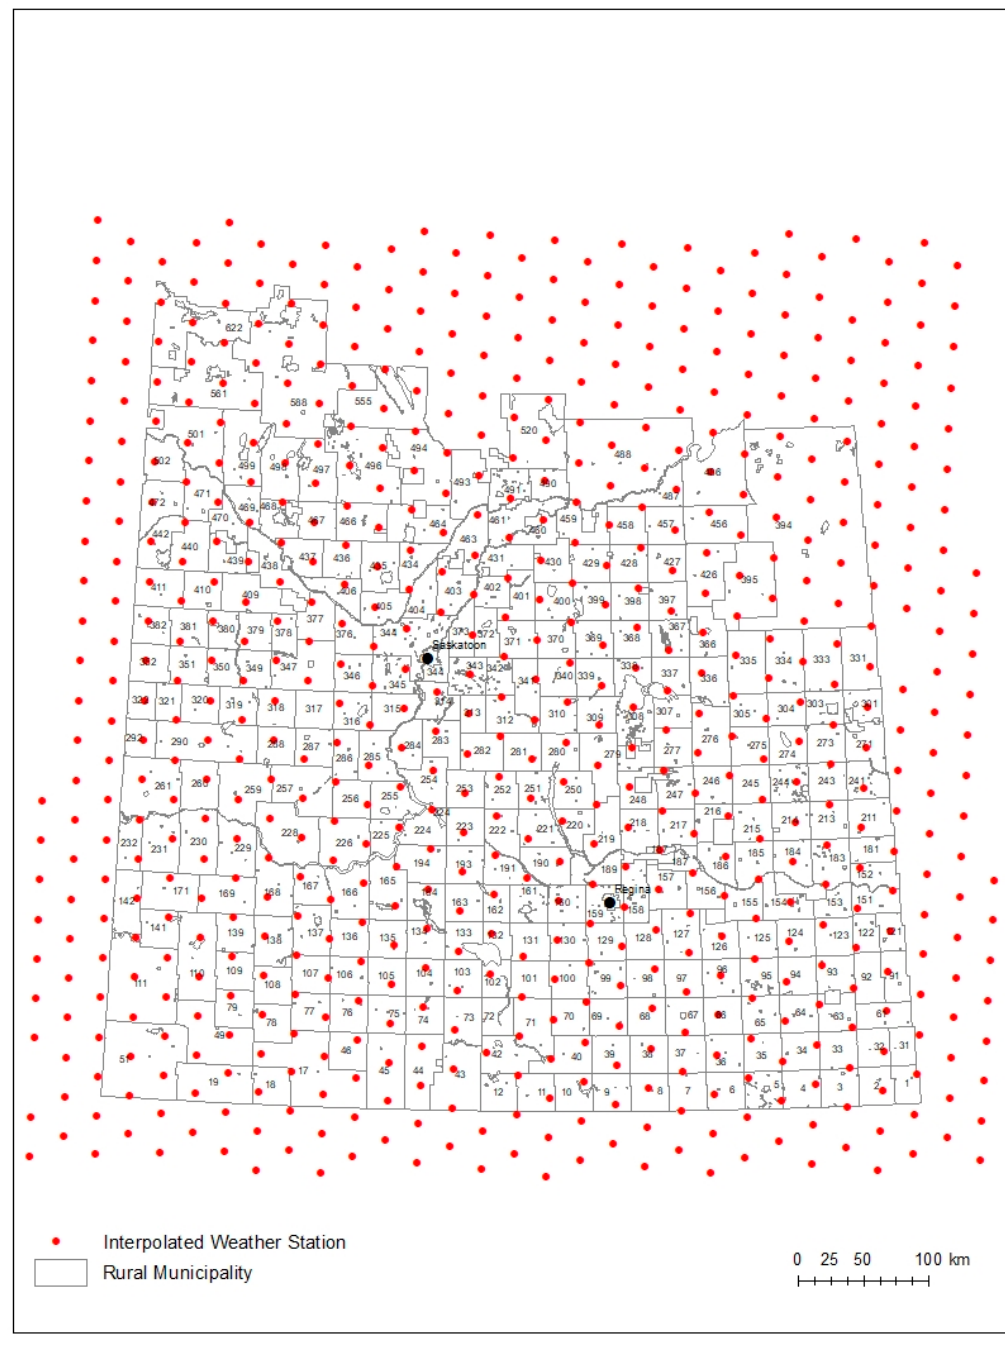
Figure 3. Interpolated weather station (1979–2016) network and rural municipality (RM) boundaries.